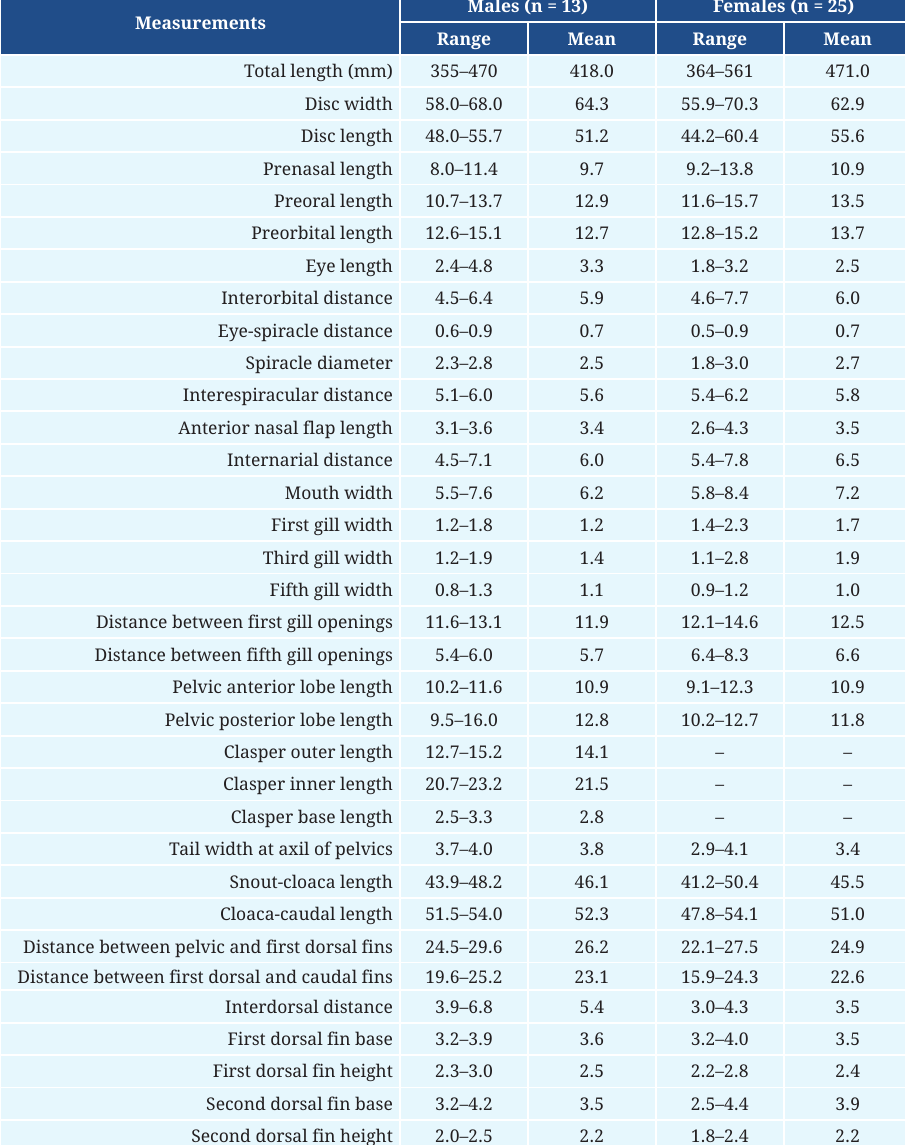
TABLE 1 | Body measurements of males and females of Rioraja agassizii . Total length (TL) in millimeters and other measurements as percentages of total length (%